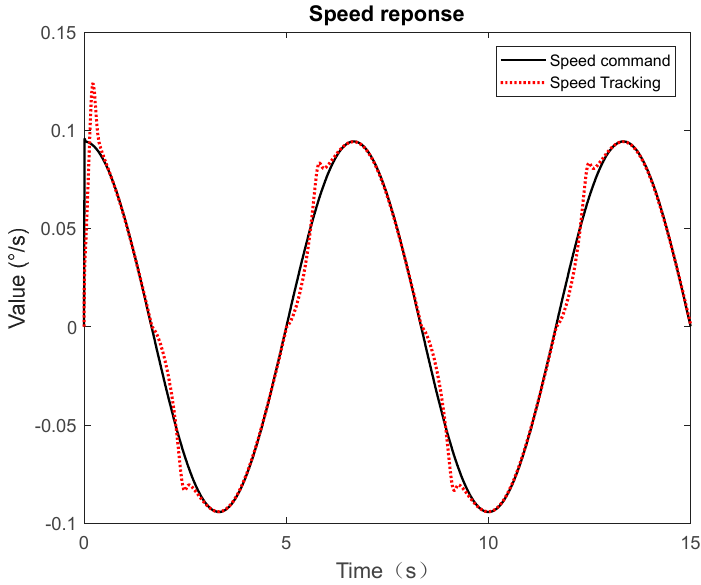
Figure 4. Speed response under friction.